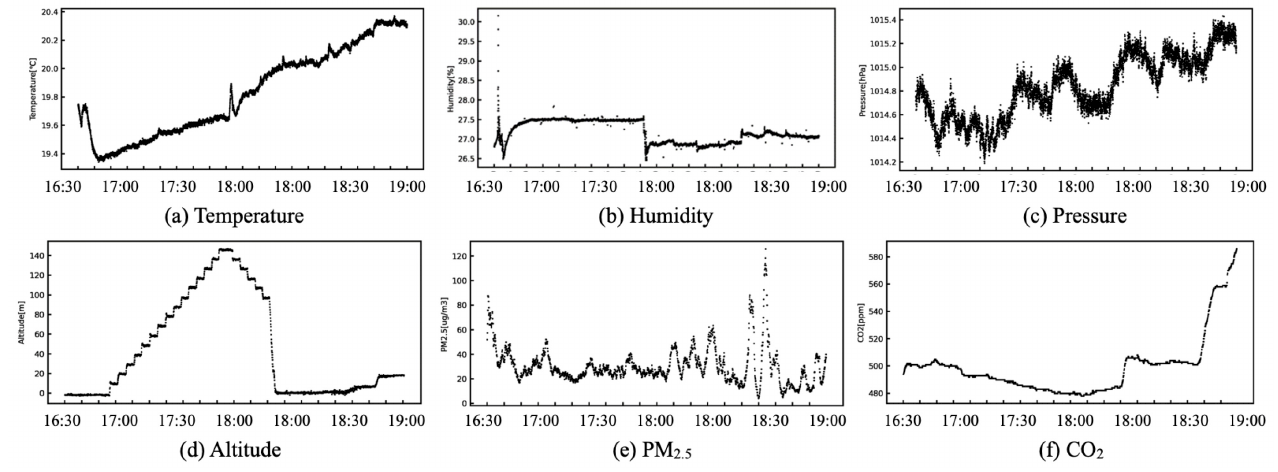
Figure 6. Visualization of measurement signals on real-time visualization system